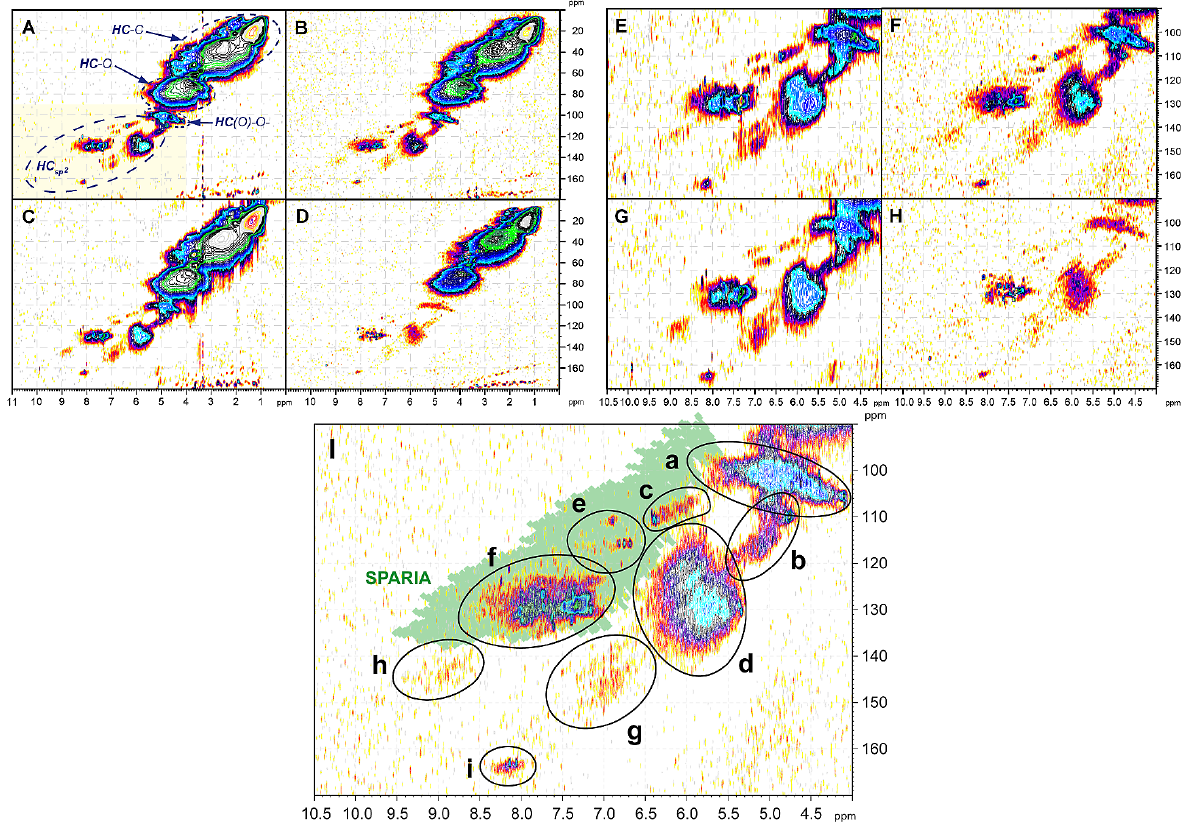
Fig. 13. 1 H, 13 CHSQCNMR cross peaks of four marine SPE-DOM with (A) four major chemical environments indicated ( (A, E) : 5m (near- surface photic zone); (B, F) 48m (fluorescence maximum); (C, G) 200m (upper mesopelagic zone); (D, H) 5446m (30m above seafloor)) with sensitivity enhanced apodization to emphasize less abundant sp 2 -hybridized carbon environments in marine SPE-DOM. (A–D) full spectra δ H = 0–11ppm; (E–H) section of unsaturated (olefinic and aromatic) protons δ H = 5–10.5ppm; (I) section of unsaturated (olefinic and aromatic) CH pairs in surface SPE-DOM 48m (fluorescence maximum) with substructures denoted as follows: section a: anomeric CH in carbohydrates (sp 3 -hybridized); section b: isolated olefins; section c: multiply oxygenated aromatics (oxygen heterocycles), olefins; section d: C-conjugated olefins, certain five membered N-, O- and S-heterocycles ( δ H < 6.5ppm); section e: phenols, classical oxygenated NOM aromatics; section f: classical NOM aromatics with substantial fraction of carbonyl derivatives (likely COOH); at δ H > 8ppm: multiply carboxylated aromatics, classical PAH and six-membered nitrogen heterocycles; sterically uncongested polycyclic aromatic hydrocarbons; section g: α , β -unsaturated double bonds for δ C > 140ppm, including double bonds adjacent to aromatics: C- HC olefin = C olefin H -(C=O), C ar -X; section h: nitrogen heterocycles, heteroatom substituted polycyclic aromatics; and section i: specific nitrogen heterocycles, very likely with more than one nitrogen. The green area highlights the HSQC cross-peak region accessible to single benzene rings substituted by common electron withdrawing, neutral and electron-donating common substituents of natural organic matter; SPARIA: s ubstitution p atterns in a romatic r ings by i ncrement a nalysis (Perdue et al., 2007).